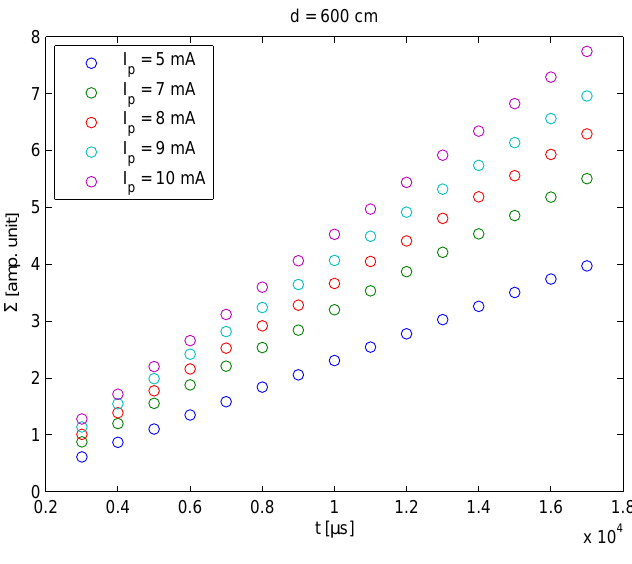
Figure 4. Behavior of (cid:6) with t over the range from 2 ms to 18 ms, considering different radiant intensities at a fixed distance between camera and